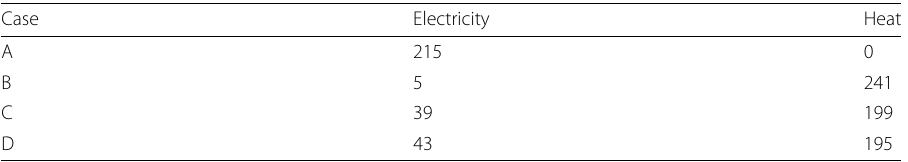
Table 5 Total energy consumptions over five days